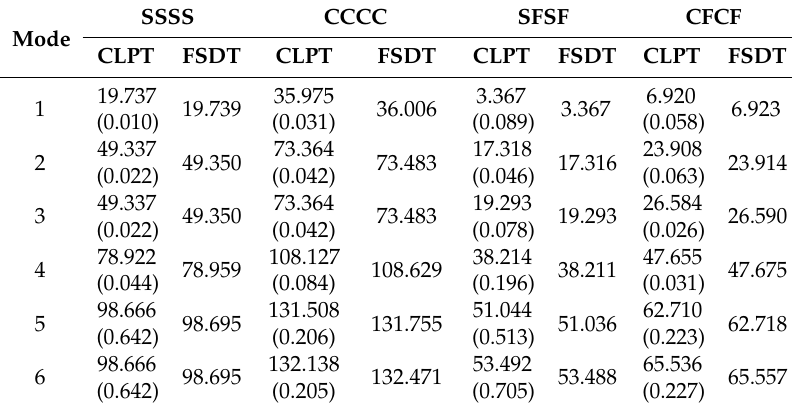
Table 1. Non-dimensional frequencies ω for α = 1.0.